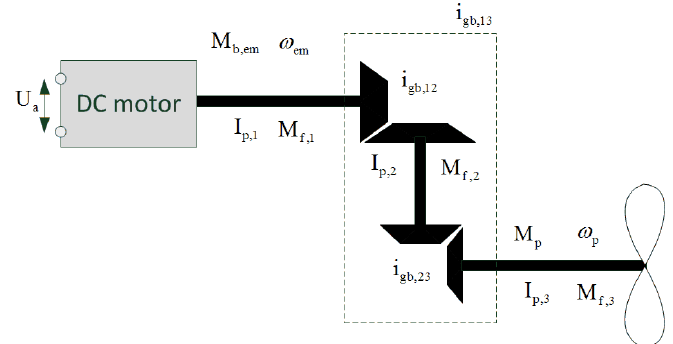
Figure 3. Schematic representation of Tito Neri drive